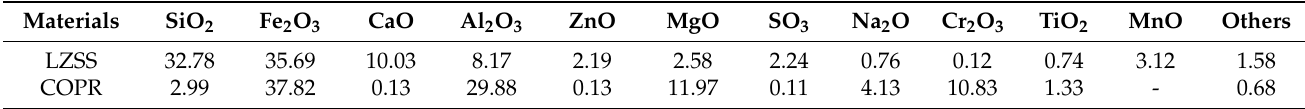
Table 1. Chemical compositions of COPR and LZSS (wt %).